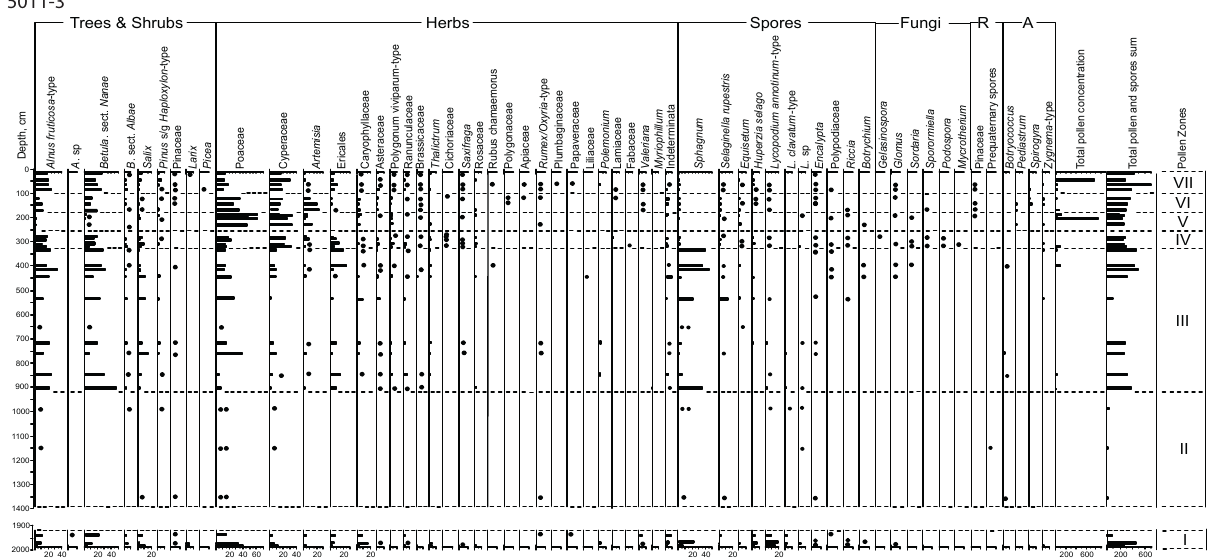
Fig. 5. Percentage pollen diagram of core 5011-3. Dots are < 2% pollen